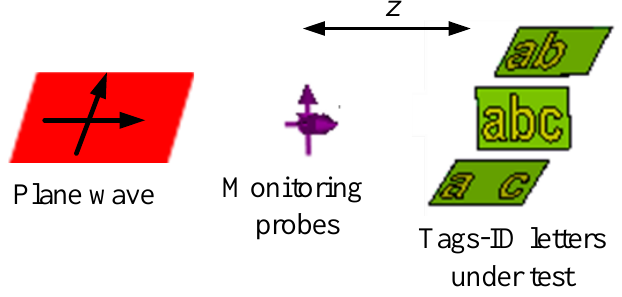
Figure 5. Simulation setup for the alphabet-based chipless tags.